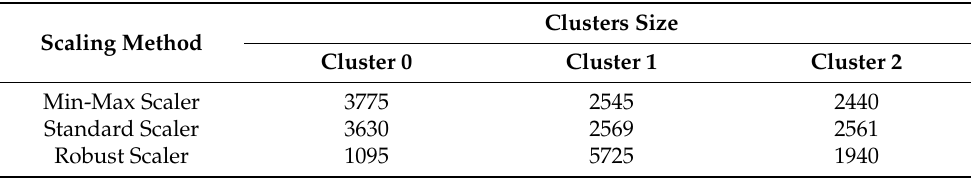
Figure 14. Metrics change for the robust-scaled data . Table 5. Cluster distribution using different scaling